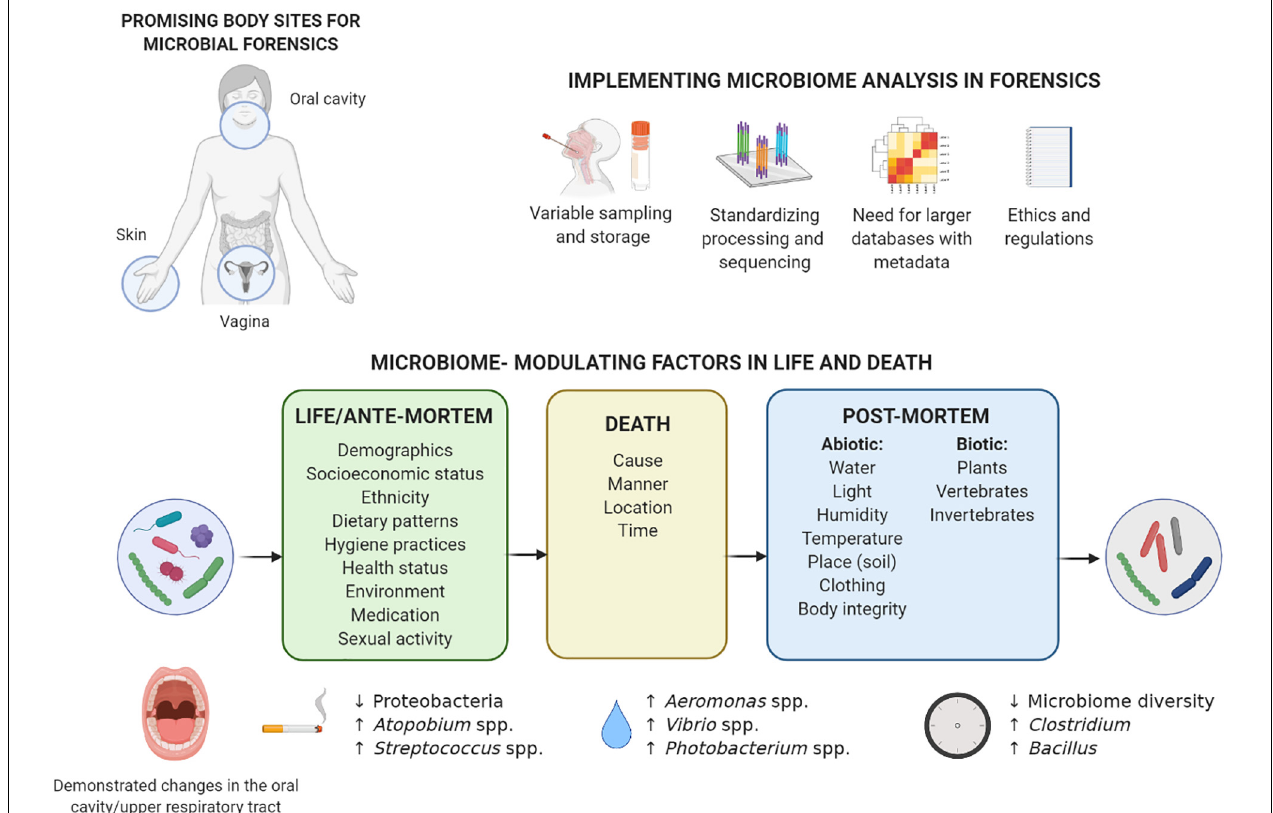
FIGURE 1 | Considerations for implementation of microbiome analysis in forensics and overview of factors in life and death that can influence the microbiome composition. The microbiome of the three body sites understudied in forensics (vagina, skin, and oral cavity) can be influenced by various individual factors during life, and these influences can sometimes also be detected after death. Death forms a turning point for the microbiome: the post-mortem microbiome is much more influenced by a range of environmental factors. Previously described microbiome-modulating factors in life and death are summarized, with some of the most prominent examples given of specific taxa in the oral cavity/upper respiratory tract associated with smoking during life (Wu et al., 2016), drowning as cause of death (Uchiyama et al., 2012; Benbow et al., 2015), and time that has passed since death (Adserias-Garriga et al., 2017b; Javan et al., 2017; García et al., 2020). More examples for the other body sites can be found in the text, although, to the best of our knowledge, no data are available on the post-mortem microbiome of the vagina. Implementation of microbiome analysis in forensics still requires extensive standardization of sampling and processing, as well as larger reference databases with metadata and an adjusted regulatory and ethical framework. Created with